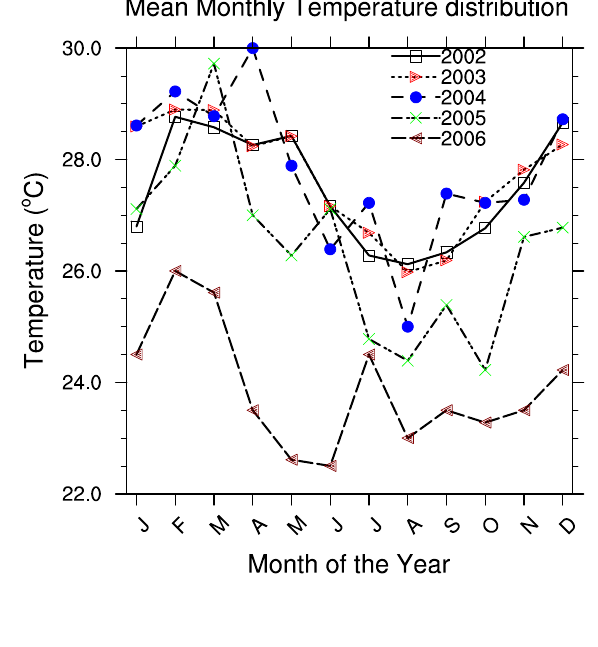
Figure 8. Mean monthly temperature distribution for the 5 years of study.